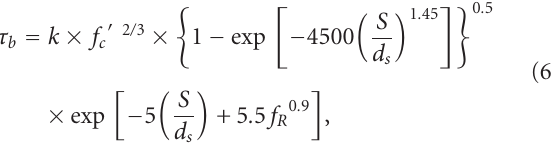
bond behavior must be influenced by many factors such as the concrete cover, the amount of confining reinforcement, or the axial force of the